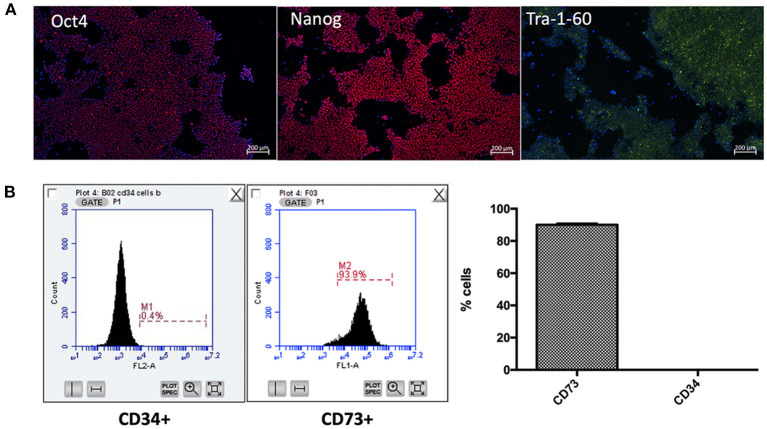
Characterization of iPSC-UkB-Ctrl-XX and generation of iMSC. Immunocytochemistry, (A) confirms pluripotency of cell line by expression of pluripotent markers Oct4, Nanog and Tra-1-60. (B) FACS sorting for CD73 and CD34 confirms that no cells are expressing hematopoietic stem cell marker CD34 and are positive for mesenchymal stem cell marker CD73.